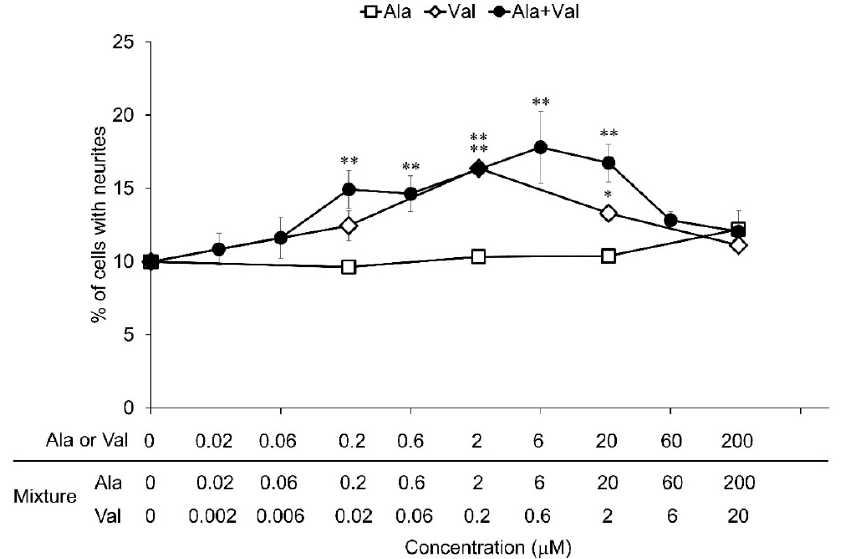
Figure 4. Neurite outgrowth-promoting activities of alanine, valine, and their mixture in the presence of Bt 2 cAMP in PC12 cells. PC12 cells were plated at 4.0 × 10 3 cells/well and cultured with the samples (final concentrations: from 0.02 µ M of alanine and 0.002 µ M of valine to 200 µ M of alanine and 20 µ M of valine) in the presence of Bt 2 cAMP (0.5 mM). The extent of neurite outgrowth was measured at 24 h and is expressed as the mean percentage of 300–400 cells. The data represent means ± standard deviation (SD) from three independent experiments. * p < 0.05, ** p < 0.01 (Dunnett’s test), as compared with the control (0.5 mM Bt 2 cAMP only).